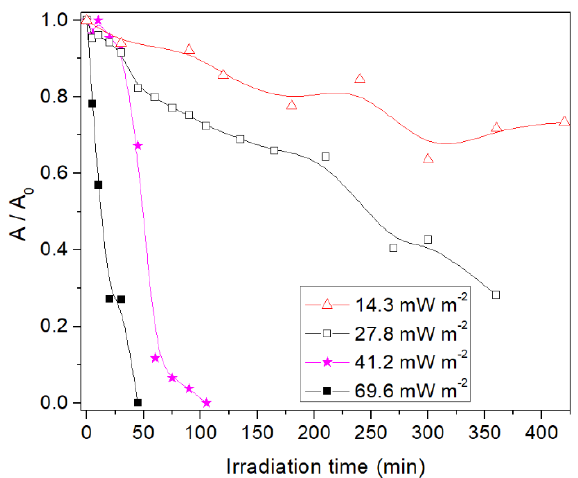
Figure 1. Decay of Ru species in solution monitored by the absorbance at 325 nm during photodeposition on TiO 2 with different incident irradiances. Solid lines are guides to the eye only. Table 1. Physicochemical characteristics of Ru/TiO 2 materials obtained by photoassisted synthesis. Sample Synthesis Time (h) Ru wt.% a